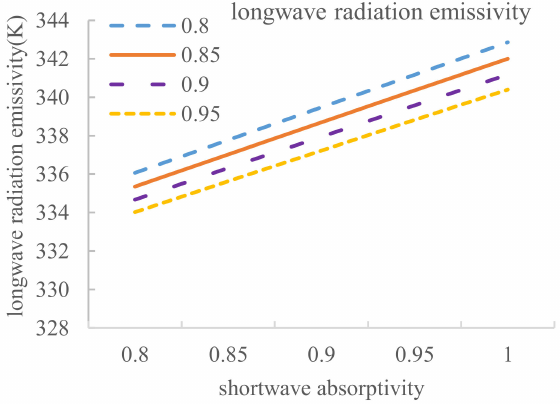
Figure 17. Relationship between pavement equilibrium temperature and the shortwave